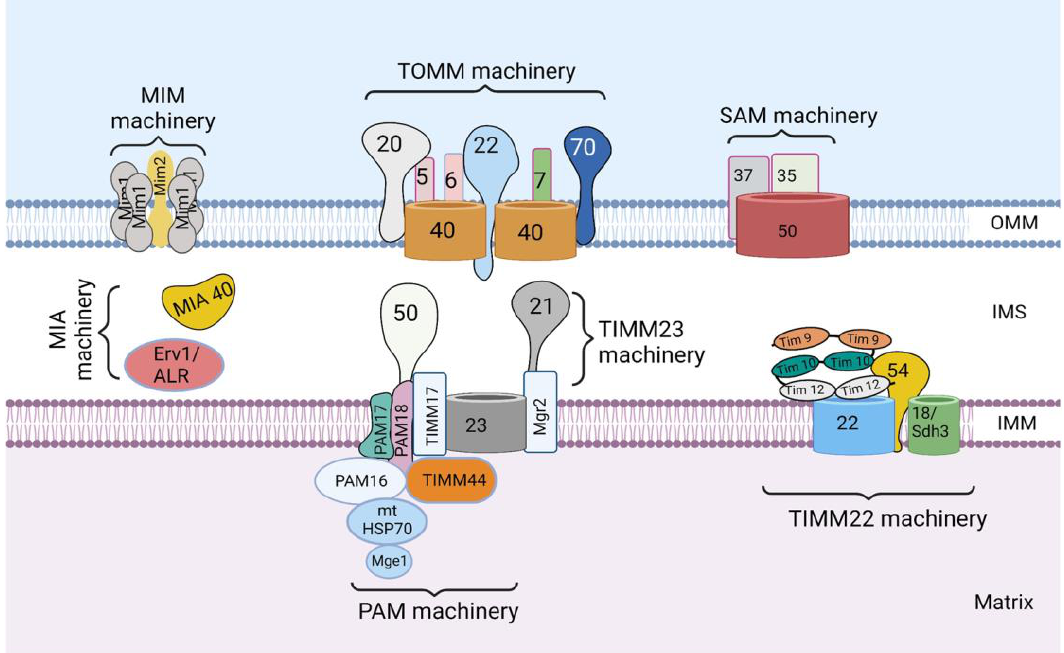
Figure 1. The mitochondrial protein import system. The mitochondrial protein import system consists of seven machineries, including the translocase of the outer mitochondrial membrane (TOMM) machinery, mitochondrial import machinery (MIM), sorting and assembly machinery (SAM), mitochondrial intermembrane space import and assembly machinery (MIA), translocase of the inner mitochondrial membrane 23 (TIMM 23) machinery, translocase of the inner mitochondrial membrane 22 (TIMM 22) machinery, and a presequence-associated motor (PAM). The figure was created with